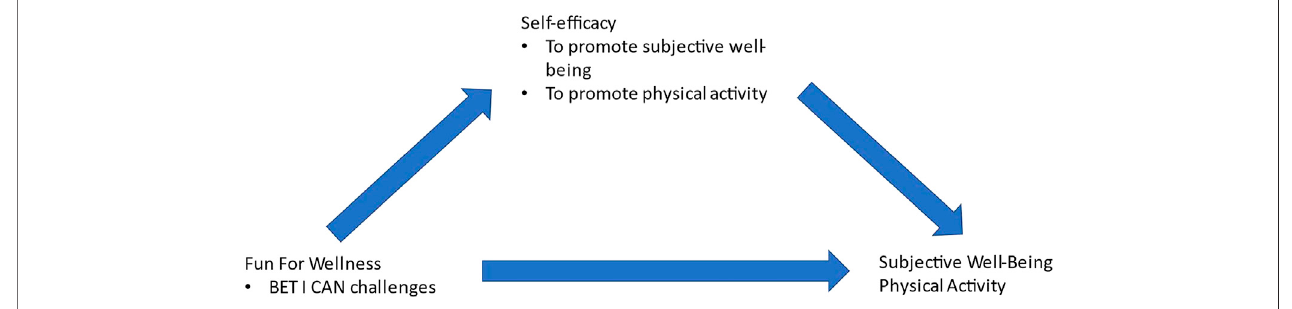
FIGURE 1 | The Fun For Wellness conceptual model for the promotion of self-ef fi cacy, subjective well-being and physical activity.